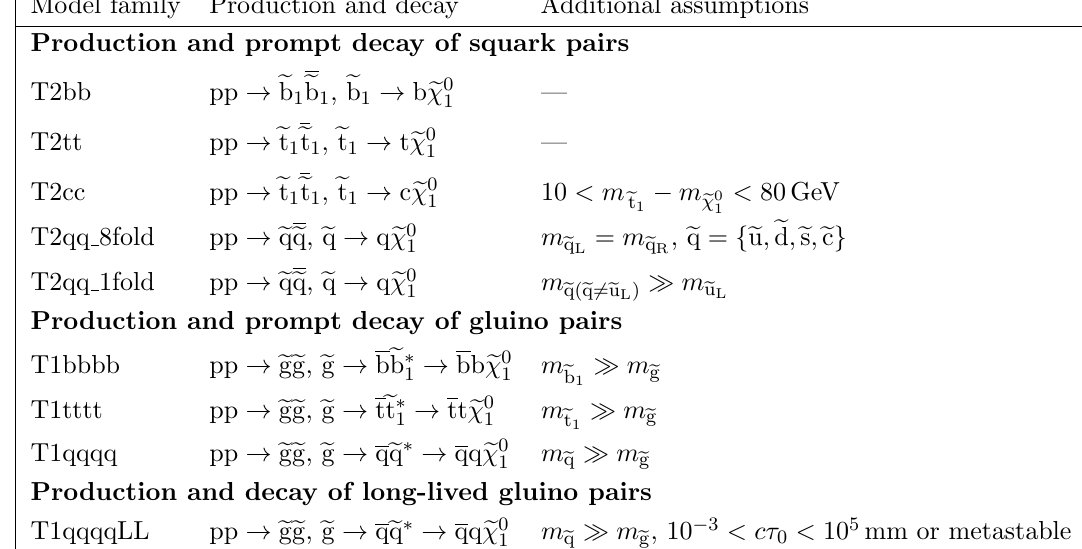
Table 3 . Summary of the simpli(cid:12)ed SUSY models used to interpret the result of this